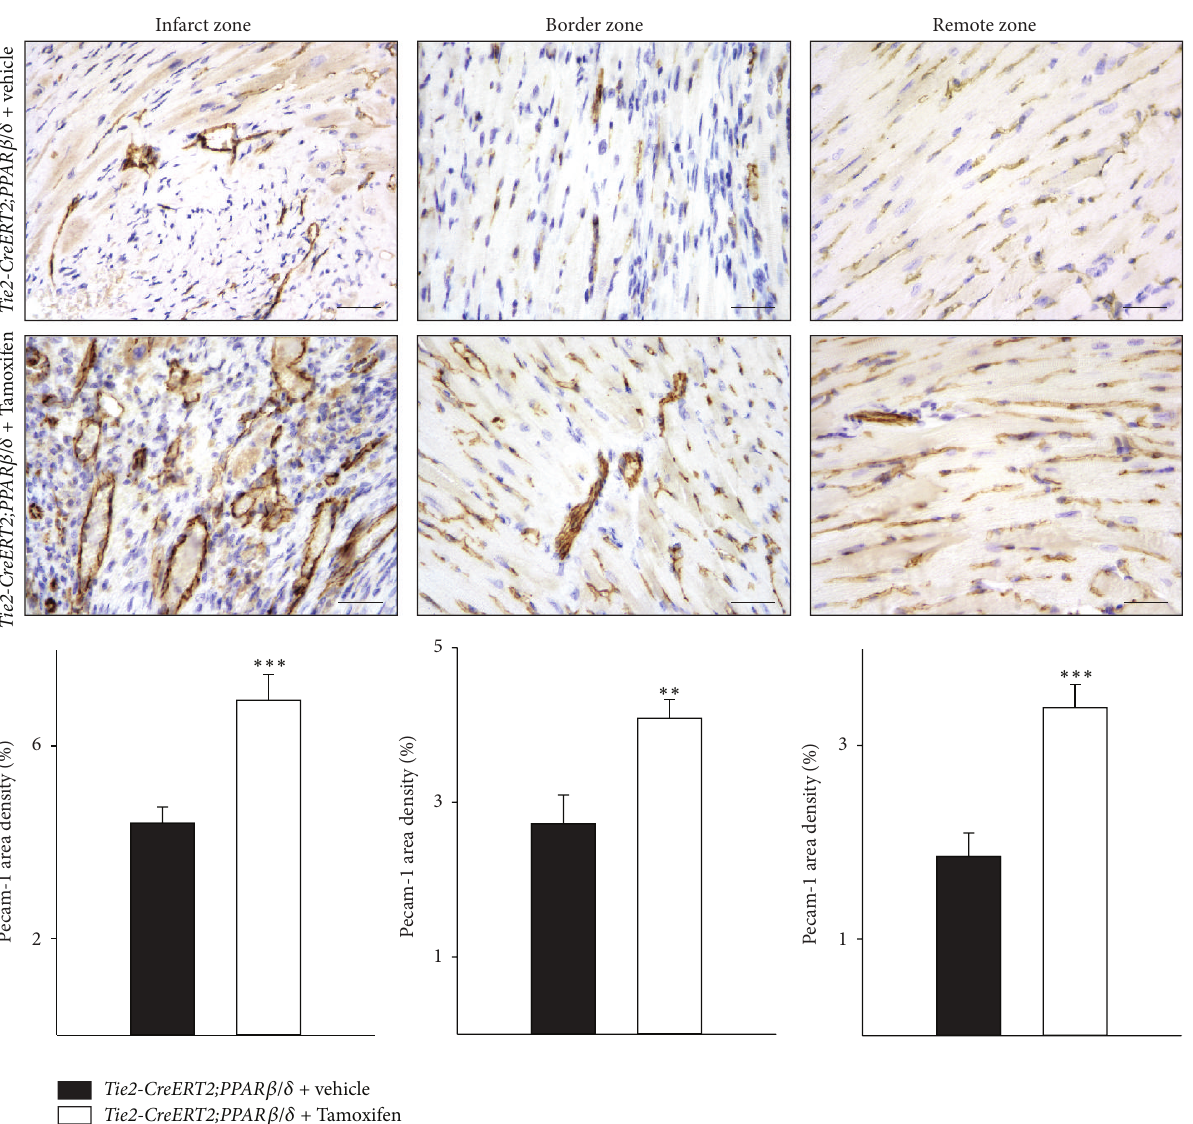
Figure 4: Increased vessel formation after myocardial infarction in the hearts of mice with vascular-specific PPAR 𝛽 / 𝛿 overexpression. Pecam- 1-immunostaining in mouse heart sections and quantification of Pecam-1 signal area density ( Tie2-CreERT2;PPAR 𝛽 / 𝛿 + Tamoxifen, 𝑛 = 5 , and Tie2-CreERT2;PPAR 𝛽 / 𝛿 + vehicle, 𝑛 = 5 ). Scale bars indicate 50 𝜇 m. Data are means ± SEM. ∗∗ 𝑝 < 0.01 and ∗∗∗ 𝑝 < 0.001